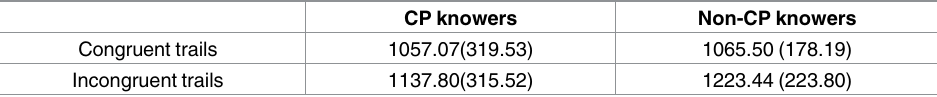
Table 1. Mean (standard deviation) RTs in groups under congruent and incongruent